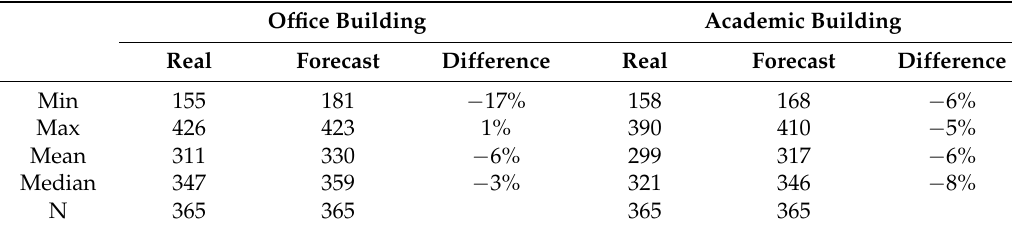
Table 7. Statistics of real and forecasted electricity consumption (Wh/m 2 ) for year 2011.